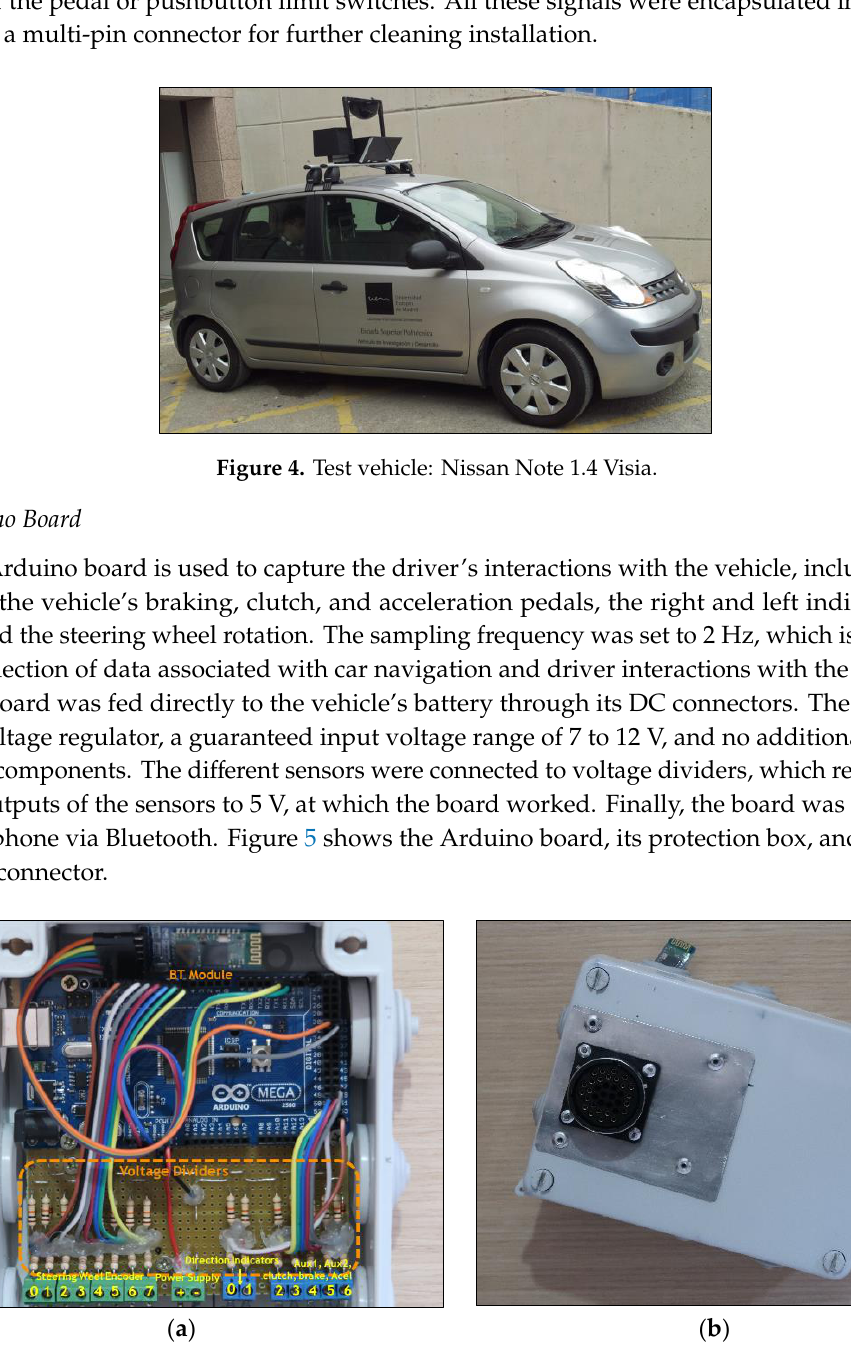
Figure 5. ( a ) Arduino Mega board and its associated electronics for data collection; ( b ) box with connection hose connector.